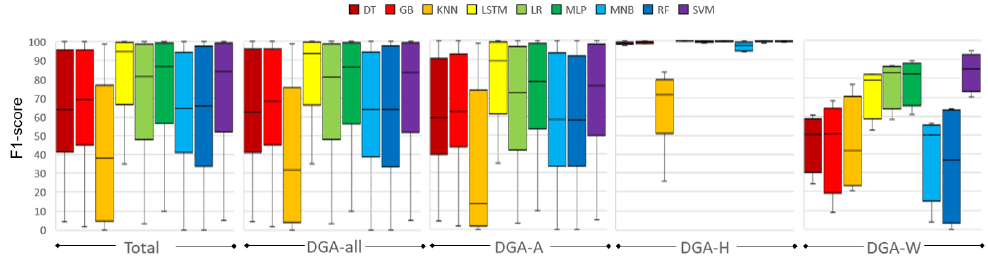
Figure 3. Boxplots of